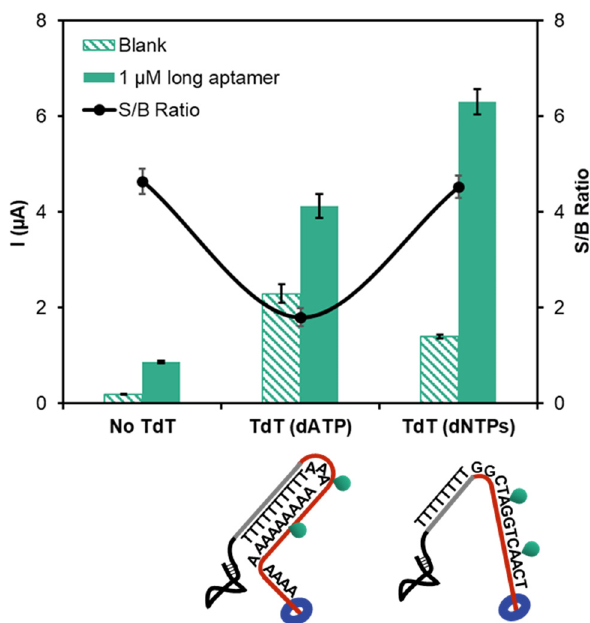
Figure 3. Chronoamperometric currents obtained without and with TdT amplification using only dATP or a mixture of dNTPs at 500 μ M concentration in the absence (striped bars) and in the presence (solid bars) of the long aptamer at 1 μ M and the corresponding signal ‐ to ‐ blank ratio at each condition.